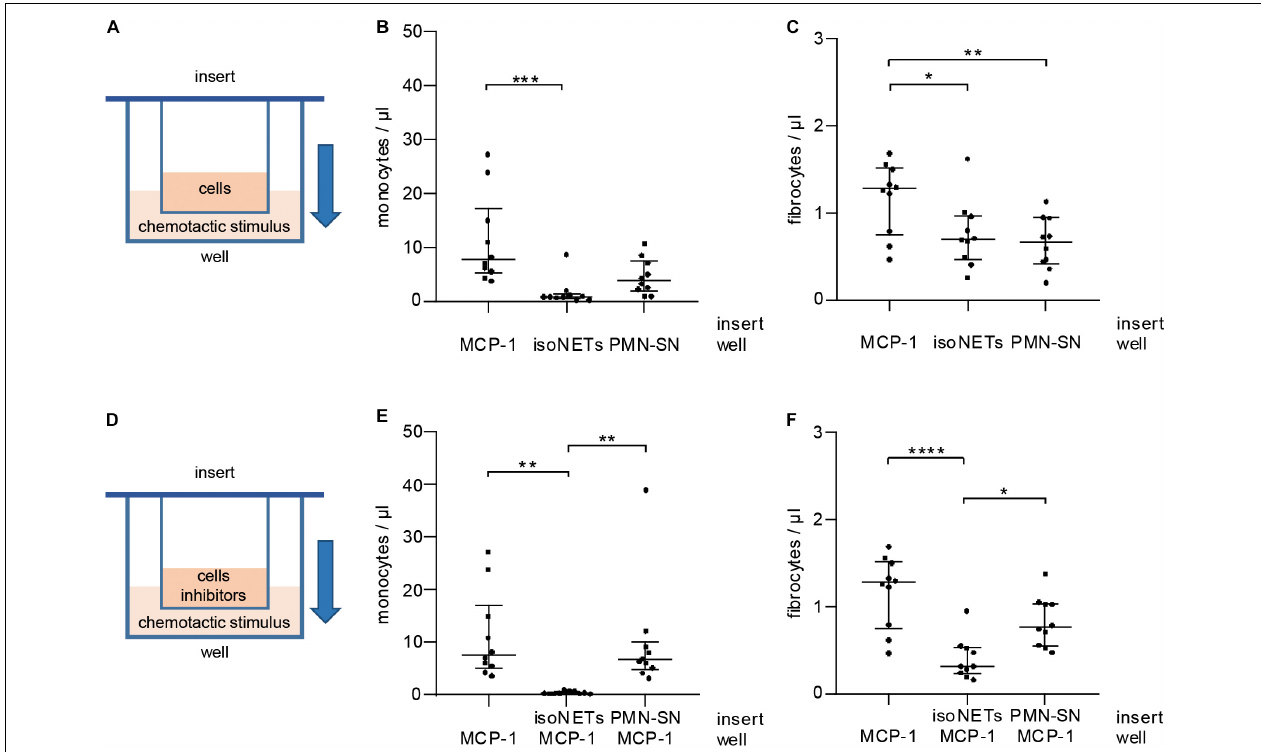
FIGURE 6 | Influence of MCP-1 and NETs on monocyte and fibrocyte migration in vitro. (A) PBMCs were subjected to chemotaxis assays using cell culture inserts. MCP-1 (500 pg/ml), NETs (500 ng/ml dsDNA content), and neutrophil control supernatant (PMN-SN) were compared as chemoattractants (well). Chemotaxis was assessed by flow cytometry recording of (B) monocyte and (C) fibrocyte cell counts/ µ l. (D) NETs (500 ng/ml dsDNA content) and neutrophil control supernatant were investigated as inhibitors of MCP-1-mediated migration. Migrated cells were stained and counted by flow cytometry recording (E) monocytes and (F) fibrocytes/ µ l. Experiments were repeated with PBMCs and NETs of 10 healthy donors. Monocyte counts of graphs (B,E) were compared with Friedman test followed by Dunn’s multiple comparisons test, and fibrocyte counts of graphs (C,D) were analyzed by repeated measures ANOVA followed by Tukey’s multiple comparisons test. * p < 0.05, ** p < 0.01, *** p < 0.001, **** p <